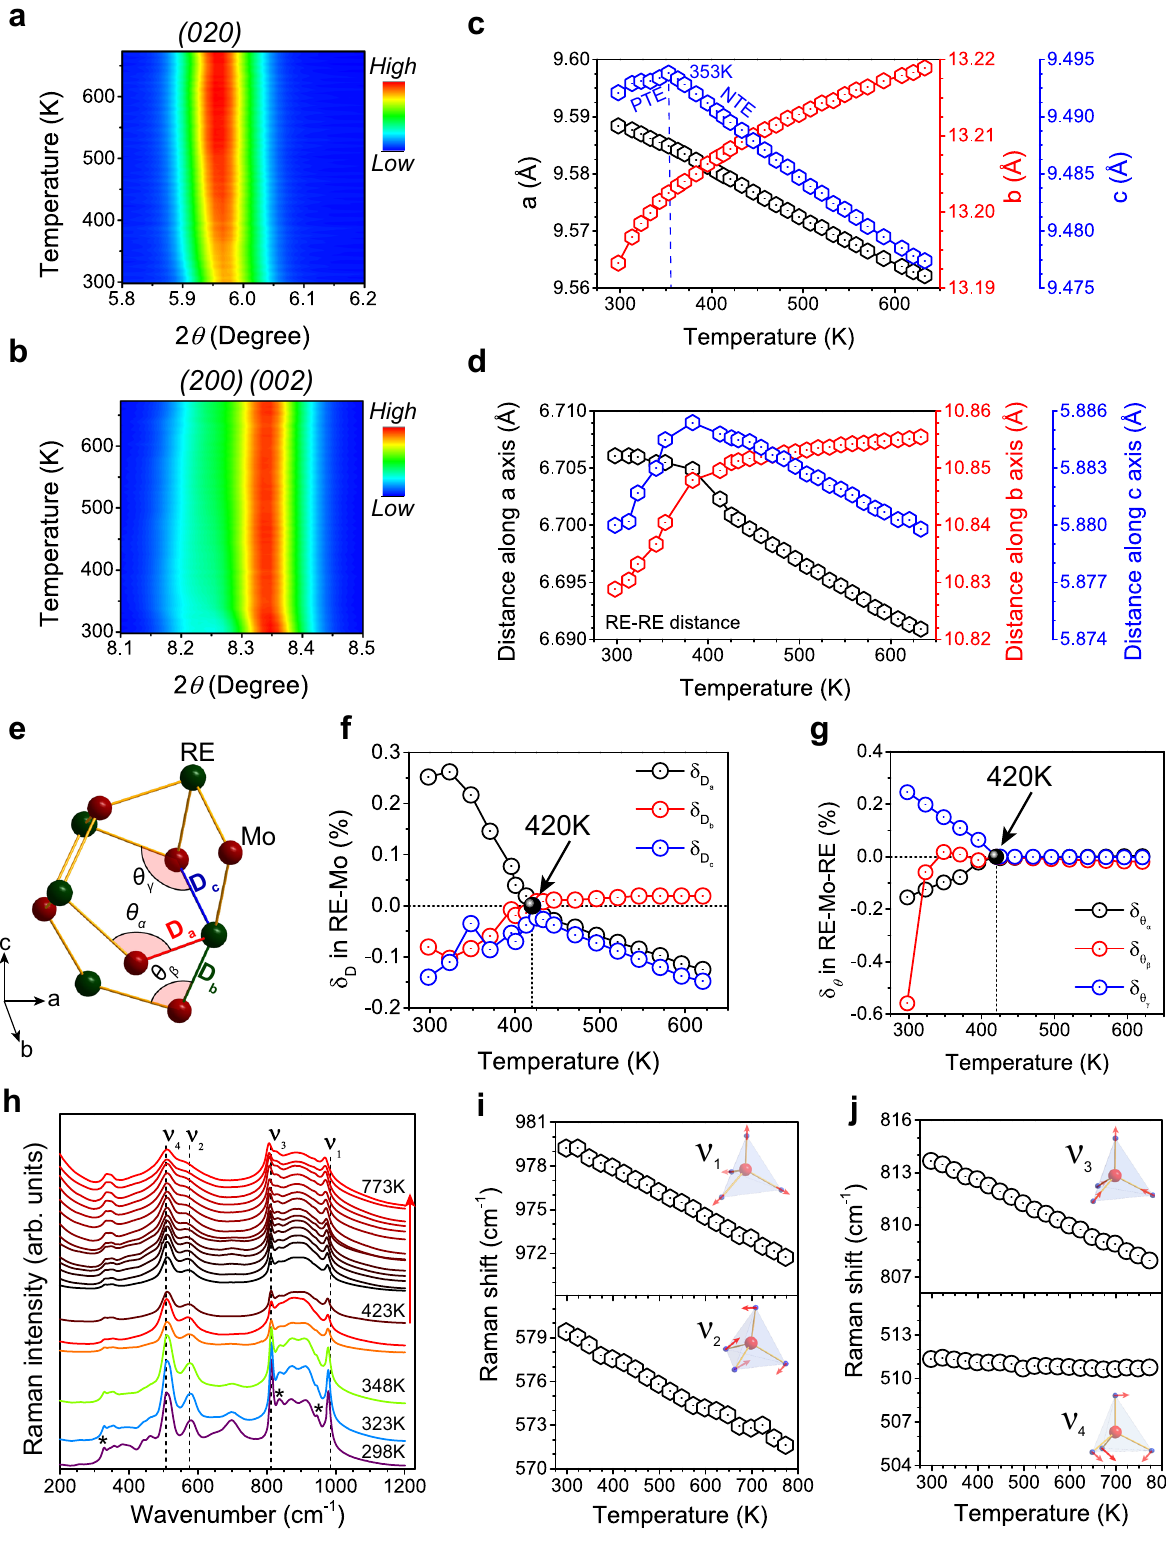
from the 4 I 13/2 → 4 I 15/2 transition. The emission intensity also displays a signi fi cant enhancement with increasing the tempera- ture from 298 to 773 K (Fig. 4b), where a 450-fold enhancement of the integrated luminescence intensity was achieved (Fig. 4c). Figure 4d shows the temperature-dependent NIR photographs